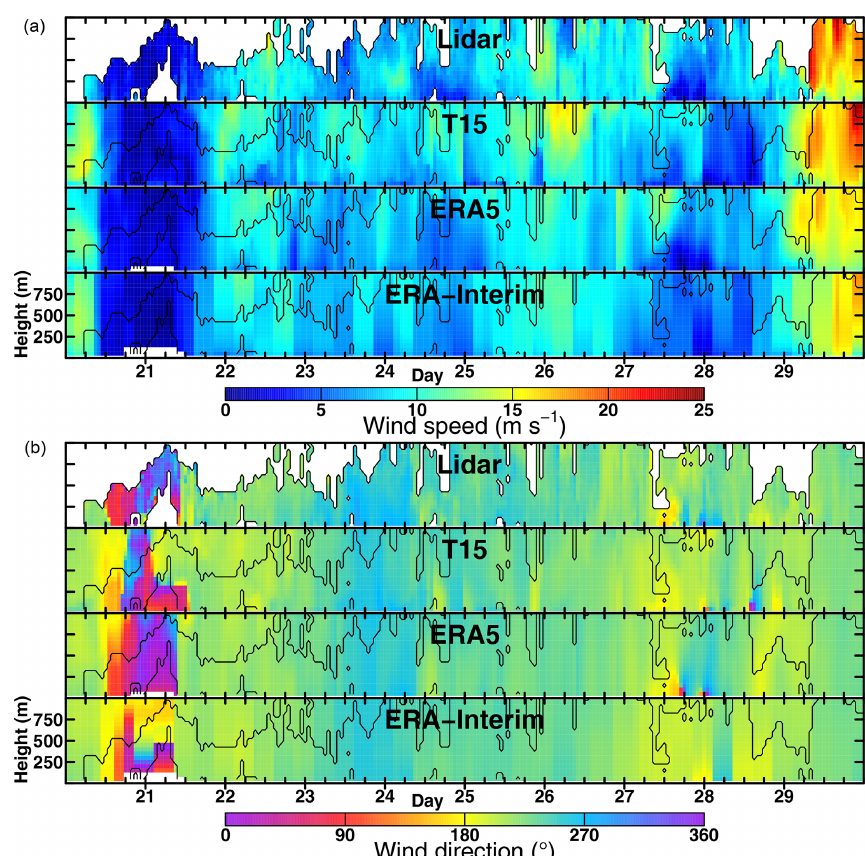
Figure 16. Time–height cross sections for (a) wind speed and (b) direction for 20 January 00:00UTC to 30 January